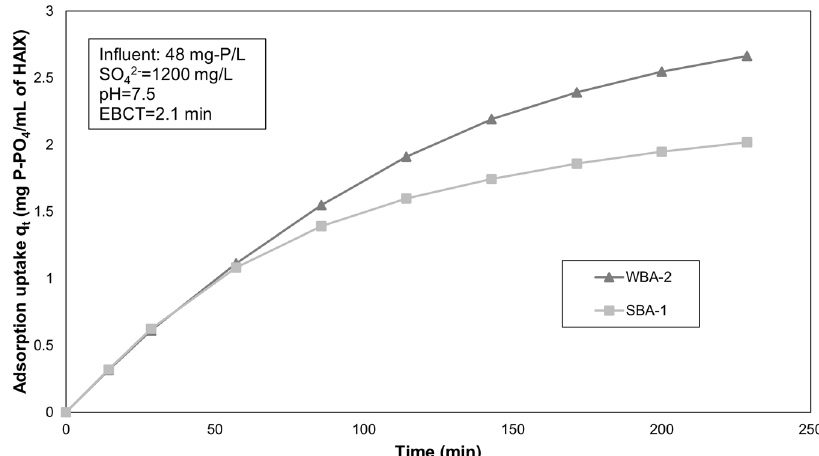
Fig. 3 Adsorption uptake of phosphate over time. Adsorption uptake (mg P-PO 4 /mL of HAIX-Nano) vs time (minutes) for WBA-2 and SBA-1.